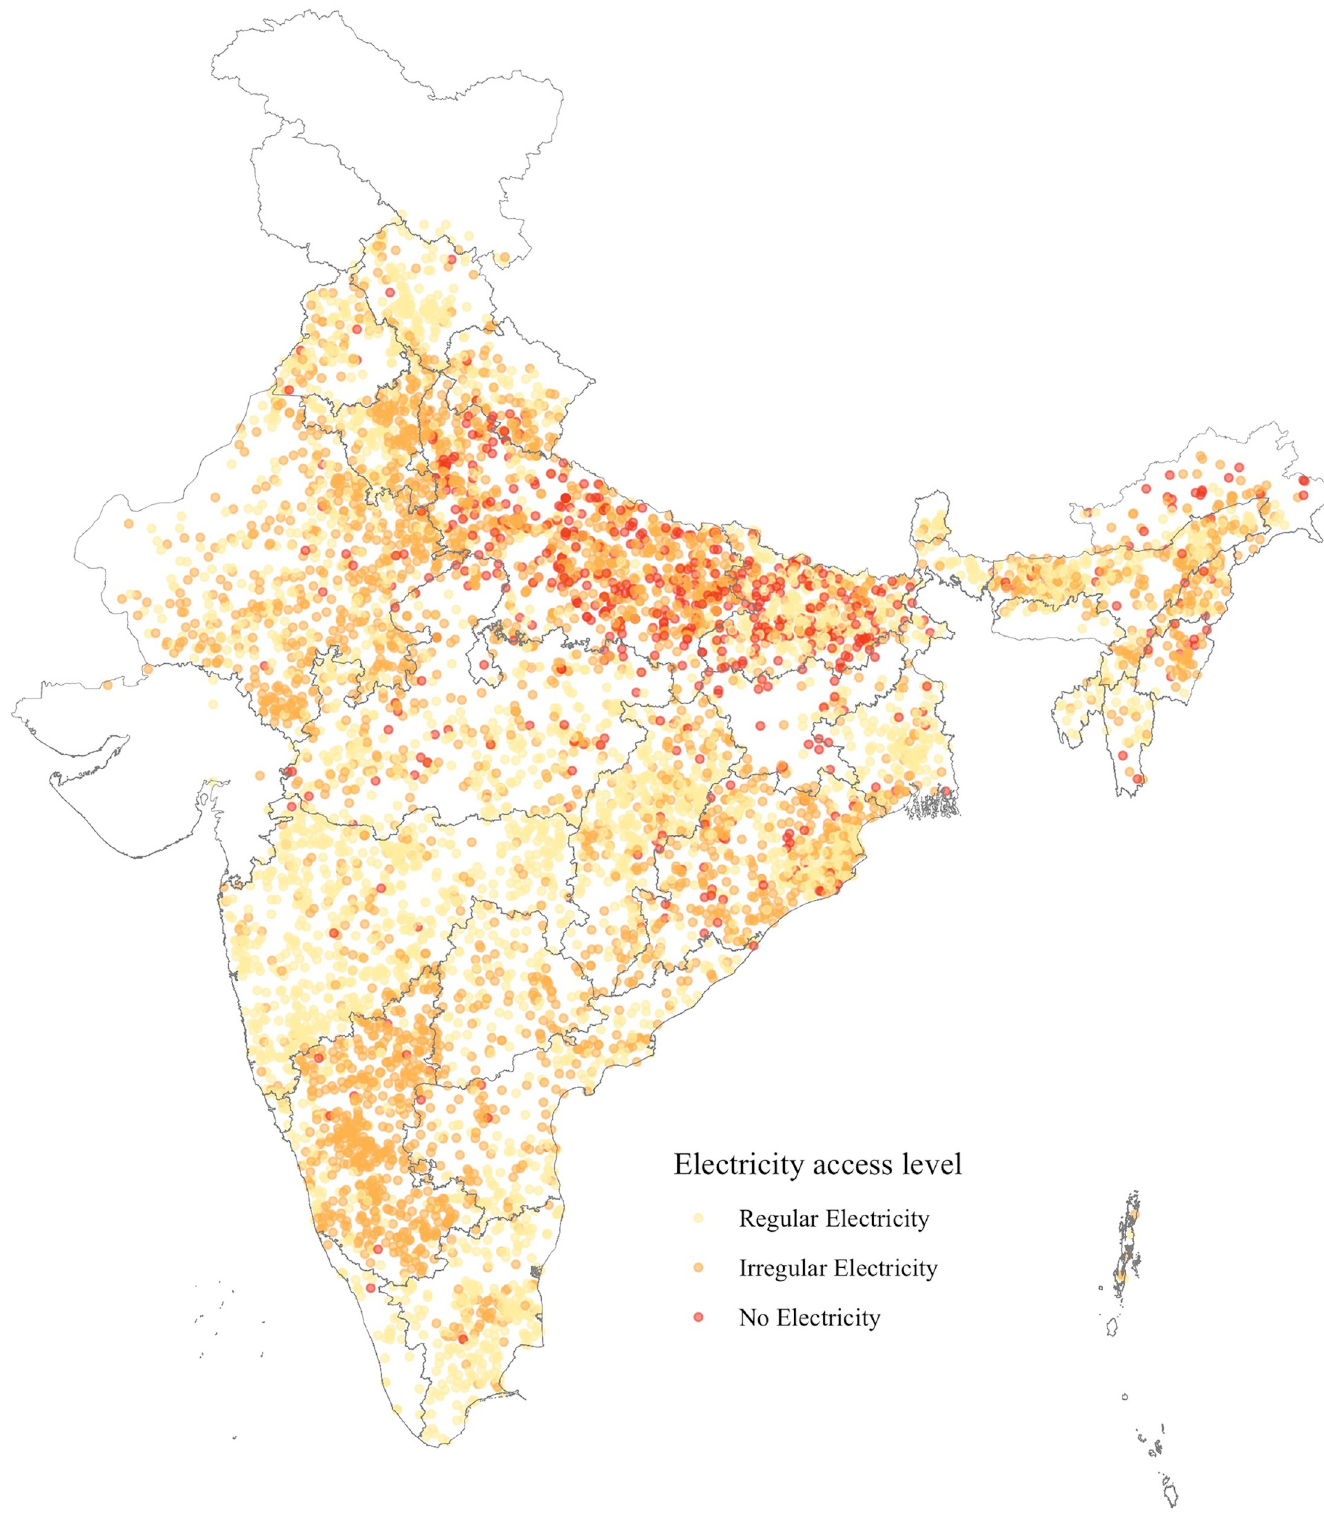
Fig 3. Distribution of PHCs in India with different levels of electricity access at the time of survey. Map created by authors. Data source : DLHS-4 . India state boundaries are reprinted from https : //github . com/datameet/maps/tree/master/States under a CC BY license , with permission from DataMeet India community , original copyright 2021 . https://doi.org/10.1371/journal.pone.0252705.g003 PLOS ONE | https://doi.org/10.1371/journal.pone.0252705 June 4,